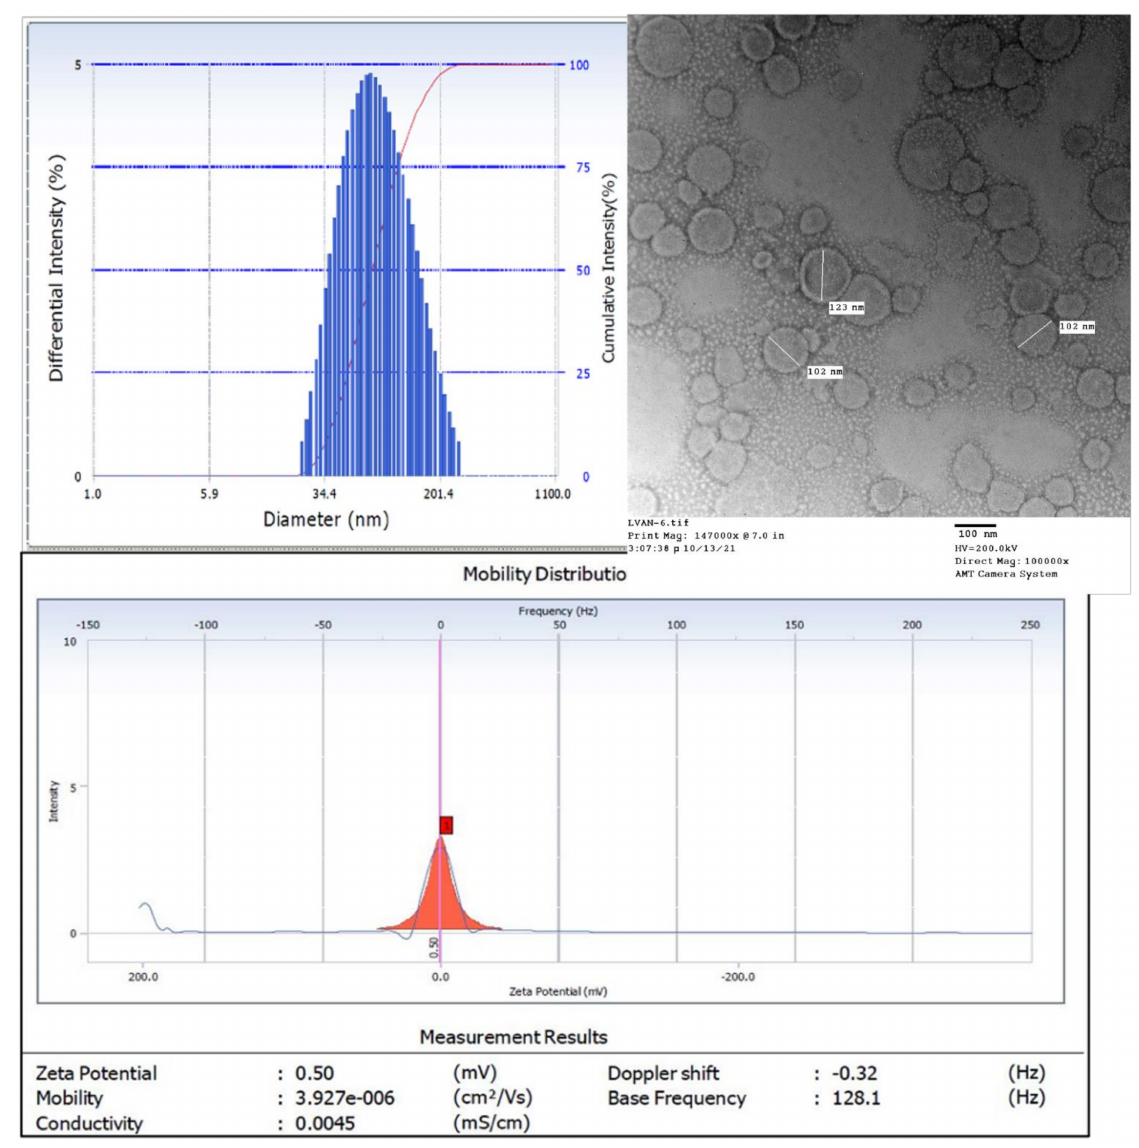
Figure 2. Uniform and homogenous nanosize distribution of LVAN as shown by DLS (top left), bilayer morphology of liposomal vesicles as shown by TEM (top right, scale bar 100 nm), and zeta potential of LVAN (bottom). Data indicate homogenous and nanosized particles, with near neutral surface charge, that are suitable for MRSA